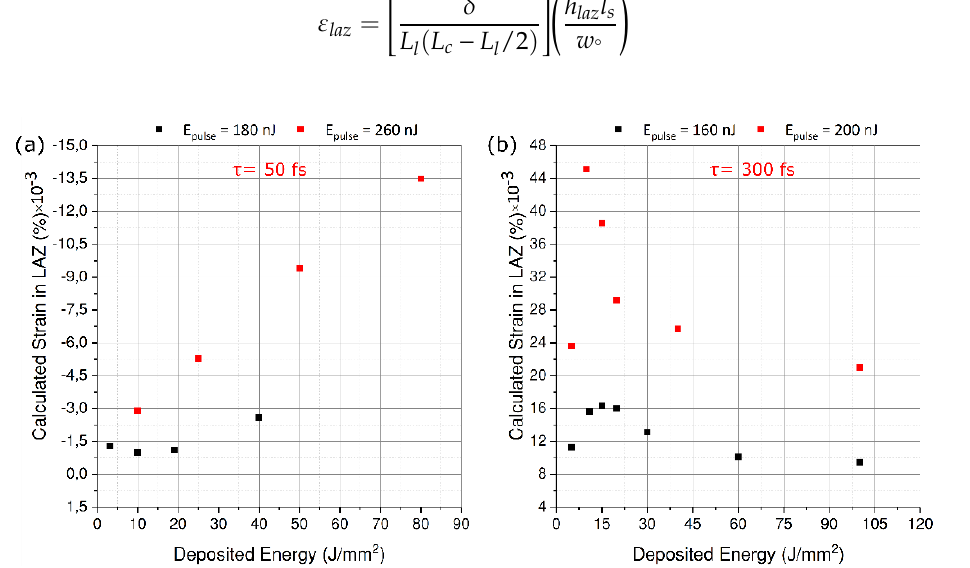
Figure 5. Strain in the laser-affected zones as a function of deposited energy for ( a ) τ = 50 fs and ( b ) τ = 300 fs and for two different pulse energies. One should note the switch from regime I ( a ) to regime II ( b ) with the increase of the pulse duration.